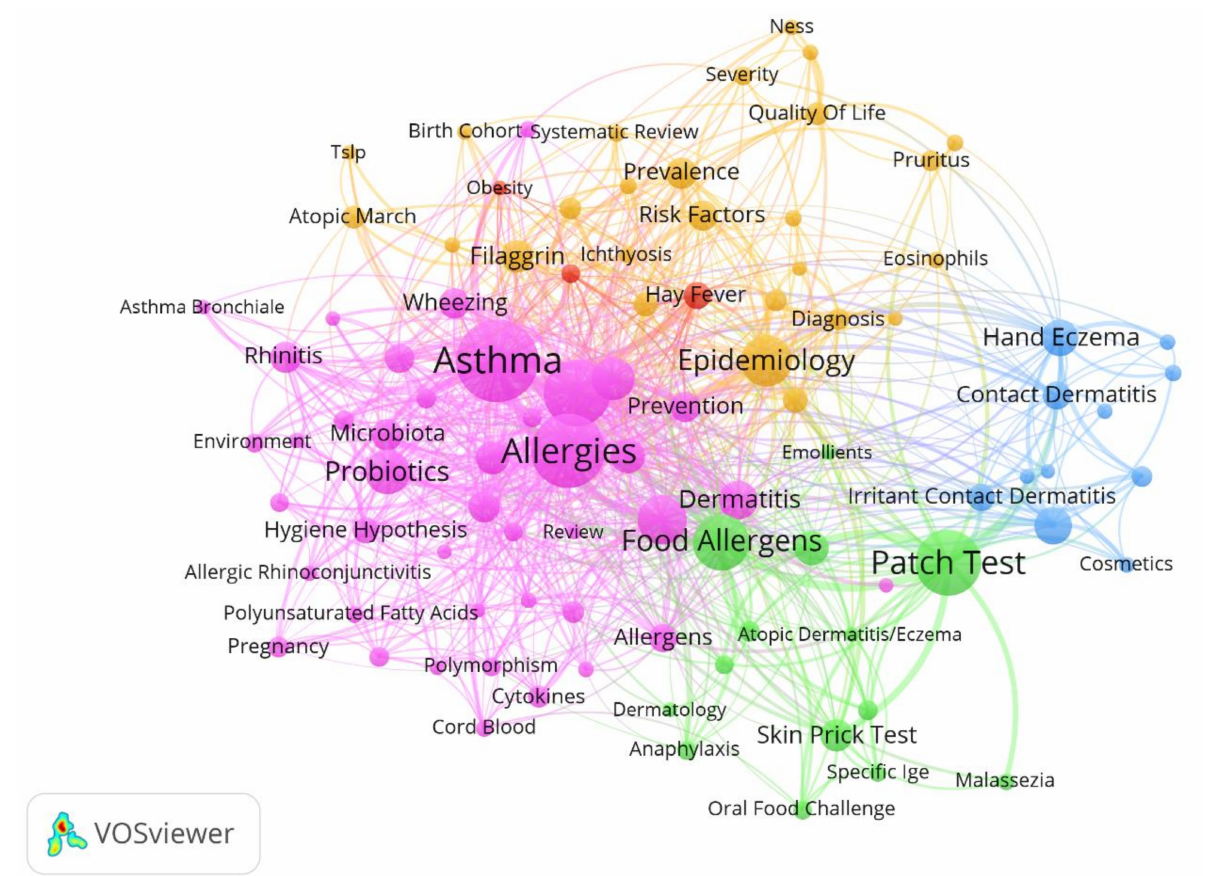
Figure 3. Network analysis of author keywords during the period 1990–2020. Keywords used more than five times were included in the network analysis; the keywords ‘atopic dermatitis’, ‘eczema’, ‘atopic eczema’, and ‘atopy’ were excluded. The following parameters for VOSviewer were used: layout attraction of 3, clustering resolution of 0.5, visualization scale of 1.3, and size variation of 0.6; node sizes were weighted based on the keyword frequencies in the clusters. Table 5. Top 10 keywords in each cluster based on keyword network analysis (sorted by total link strength). Cluster Keywords Total Link Strength Occurrences Average Publication Year